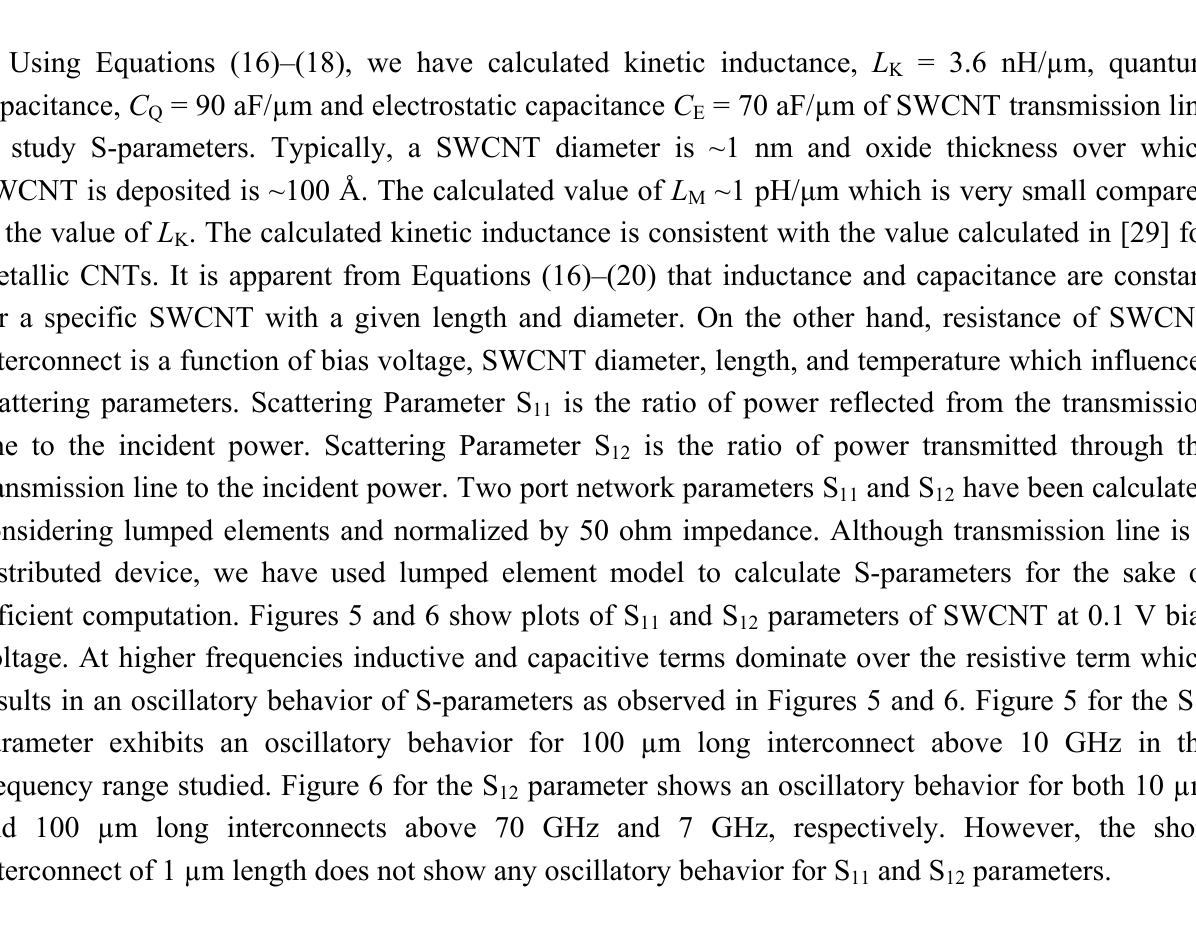
parameter of SWCNT interconnects at 0.1 V bias Figure 5. Plot of S 11